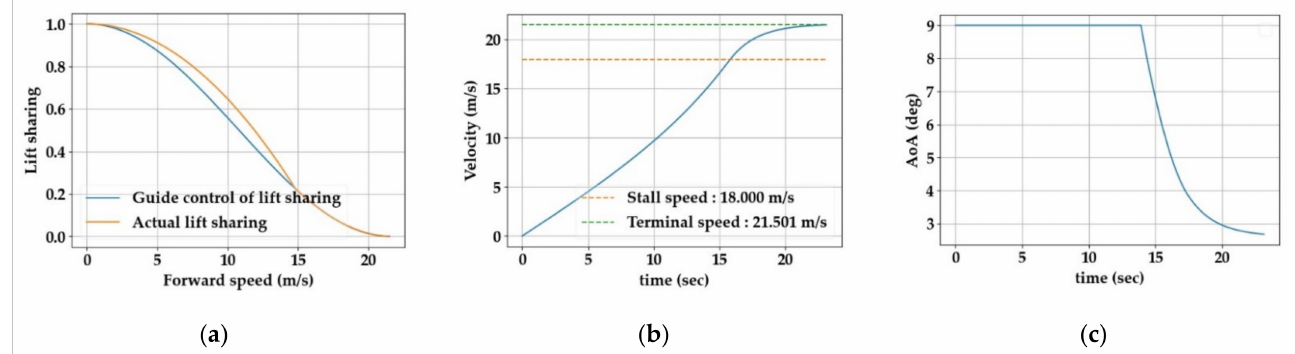
Figure 21. Transition analysis results: ( a ) shows the comparison of the guide control of lift sharing and actual lift sharing; ( b ) shows the speed change of the UAV during transition; ( c ) shows the angle of attack change of the UAV during transition. Table 12. Comparison of battery and hydrogen tank sizing results and actual data. Unit Sizing